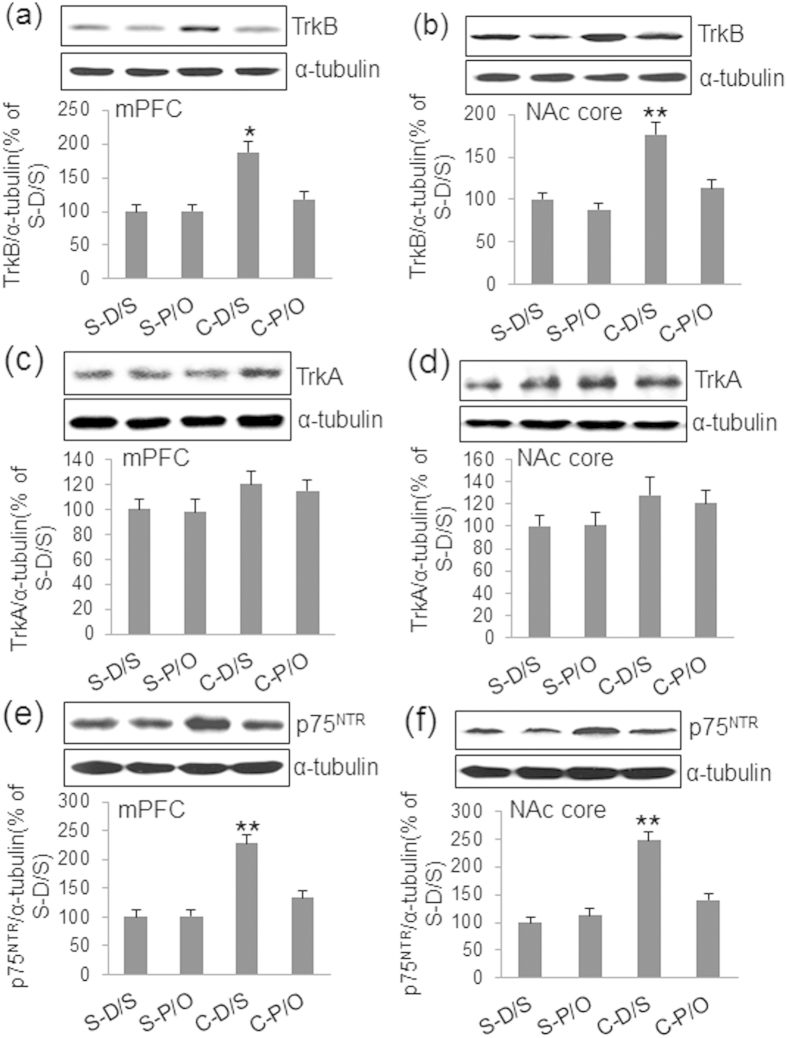
TrkA, TrkB, and p75NTR expression in the mPFC and NAc core.(a) TrkB levels in the mPFC were enhanced in the C-D/S group relative to all others. (b) TrkB levels in the NAc core were increased in the C-D/S group relative to all other groups. TrkA levels in the mPFC (c) and NAc core (d) were not significantly different between groups. (e) p75NTR level was increased in the mPFC in the C-D/S group relative to all others. (f) p75NTR levels in the NAc core were increased in the C-D/S group relative to all other groups. See Figure 1 for details of the groups. *p < 0.05, **p < 0.01, C-D/S from all other groups.